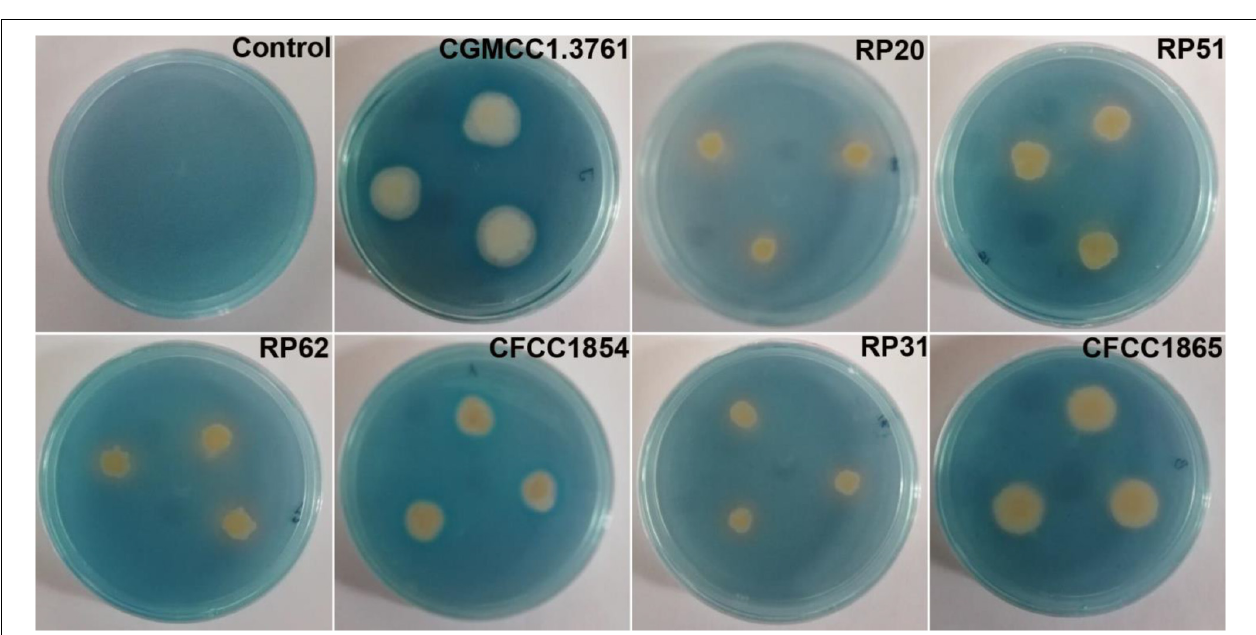
FIGURE 3 | Chrome azurol S assay shows color changes from blue to light purple or orange indicating production of catechol type or hydroxamate type siderophores from P. peoriae CGMCC 1.3761 T and nodule-inhabiting strains within Paenibacillus polymyxa complex.